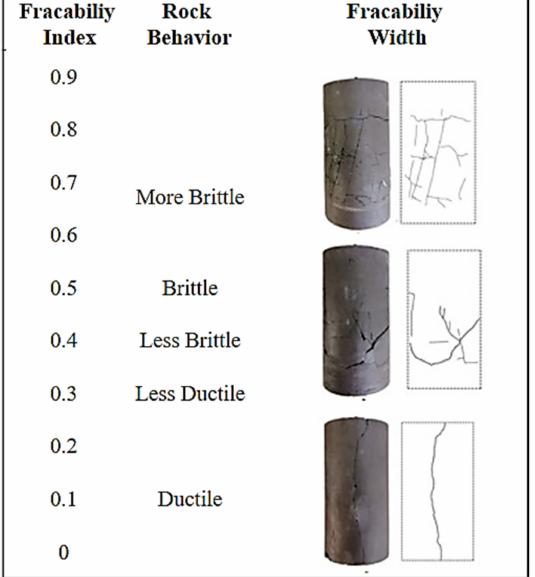
Figure 11. The improved fracability index to fracture complexity (modified after Yasin et al.